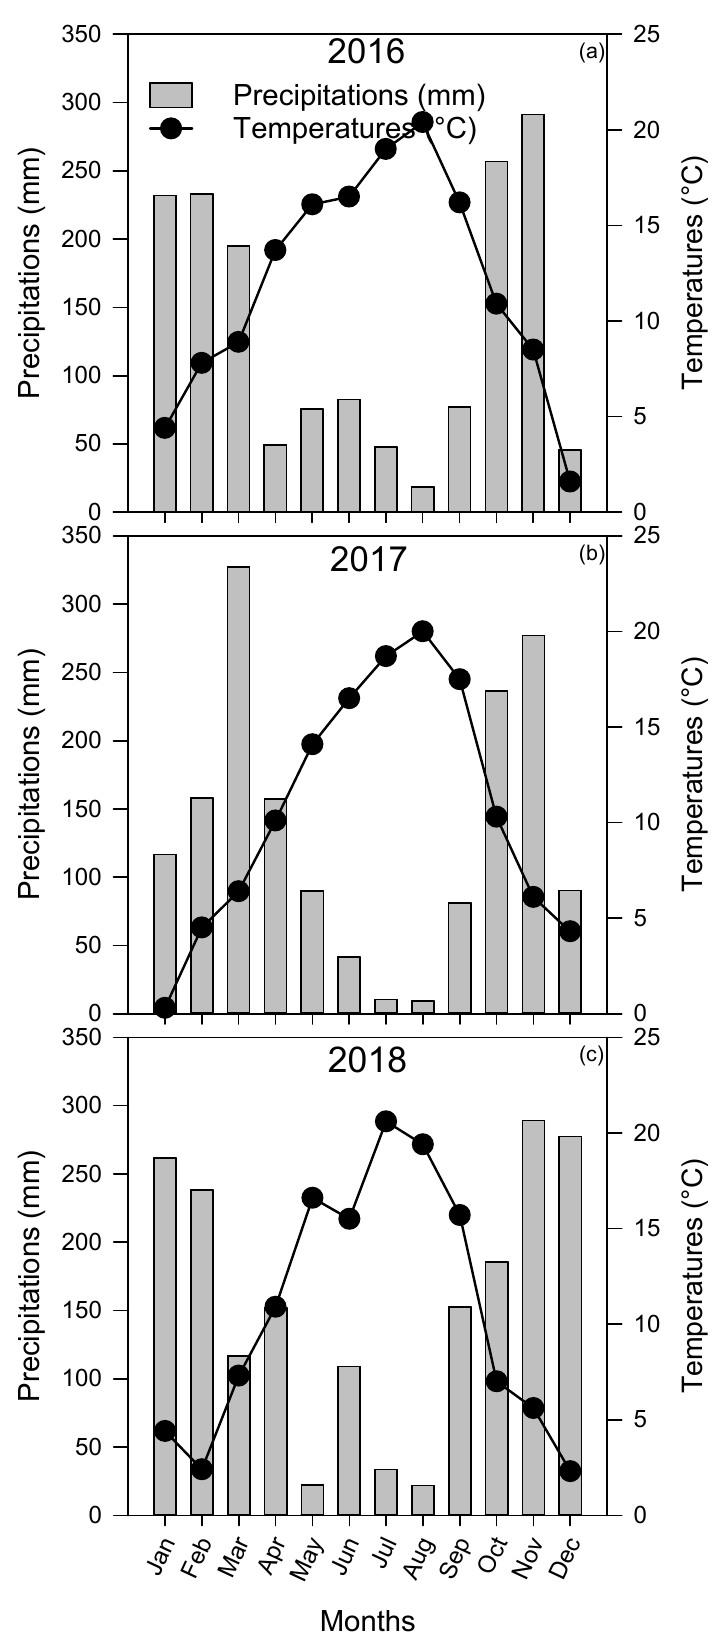
Figure 1. Average monthly precipitation and air temperatures during the periods ( a ) 2016, ( b ) 2017, and ( c ) 2018.